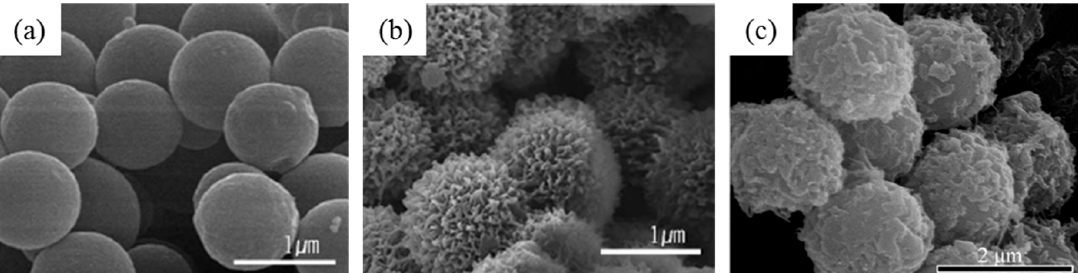
Figure 5. SEM images of: ( a ) smooth PANI@PS and ( b ) urchin-like PANI@PS, reprinted with permission